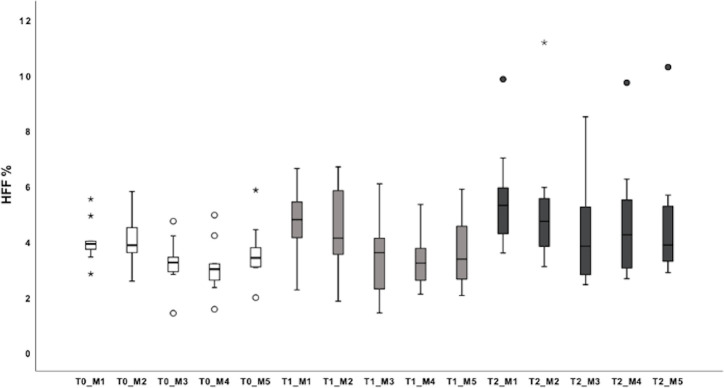
Box plots of the mean HFF measured with the different 5 methods.HFF is reported in % on x-axis. On the y-axis, the different methods of measurements are reported at the different time points: M1, M2, M3, M4, M5 at T0 with white boxes, at T1 with gray boxes, and at T2 with black boxes. For each plot, the box represents the 25th to 75th percentiles, and the dark line represents the median. Whiskers represent the highest case within 1.5-times the interquartile range and the lowest case within 1.5-times the interquartile range. Circles represent the outliers, stars extreme outliers.